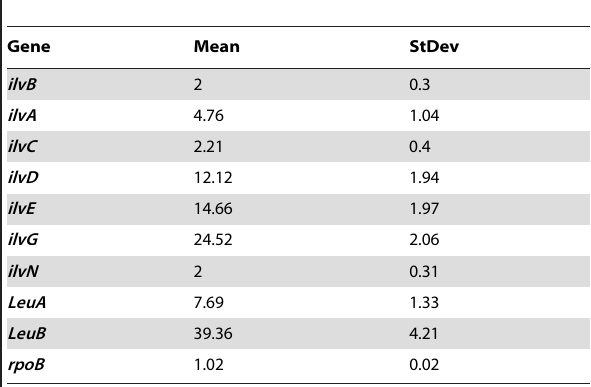
Table 1. Fold down regulation of genes in the branched chain amino-acid pathway in the ilv B antisense M. tuberculosis